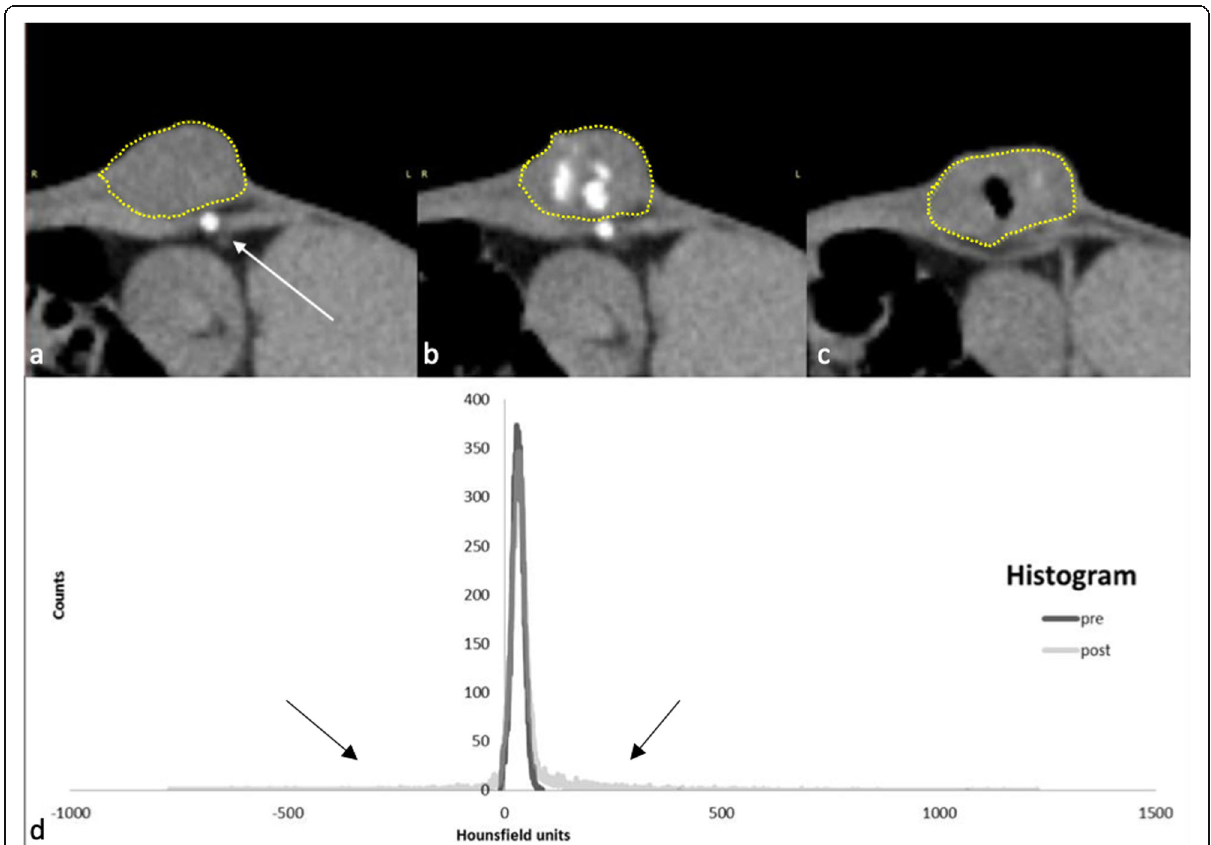
Fig. 2 Ho quantification in a subcutaneous VX-2 bearing rabbit. Rabbit 2. a Tumour before injection. The tumour is segmented with a yellow dotted line. The white arrow shows a rib. The rib is also visible in b . b Tumour after injection with accumulations of Ho microspheres, visible as white dots, indicated with white arrows. c A different axial slice shows the effect of inadvertent injection of air (black void inside the tumour). d Histogram of HU values of the entire tumour before and after injection of 166 Ho microspheres. The large negative (left of peak) and positive tail (right of peak) are caused by a relatively small number of voxels with injected air or Ho, respectively